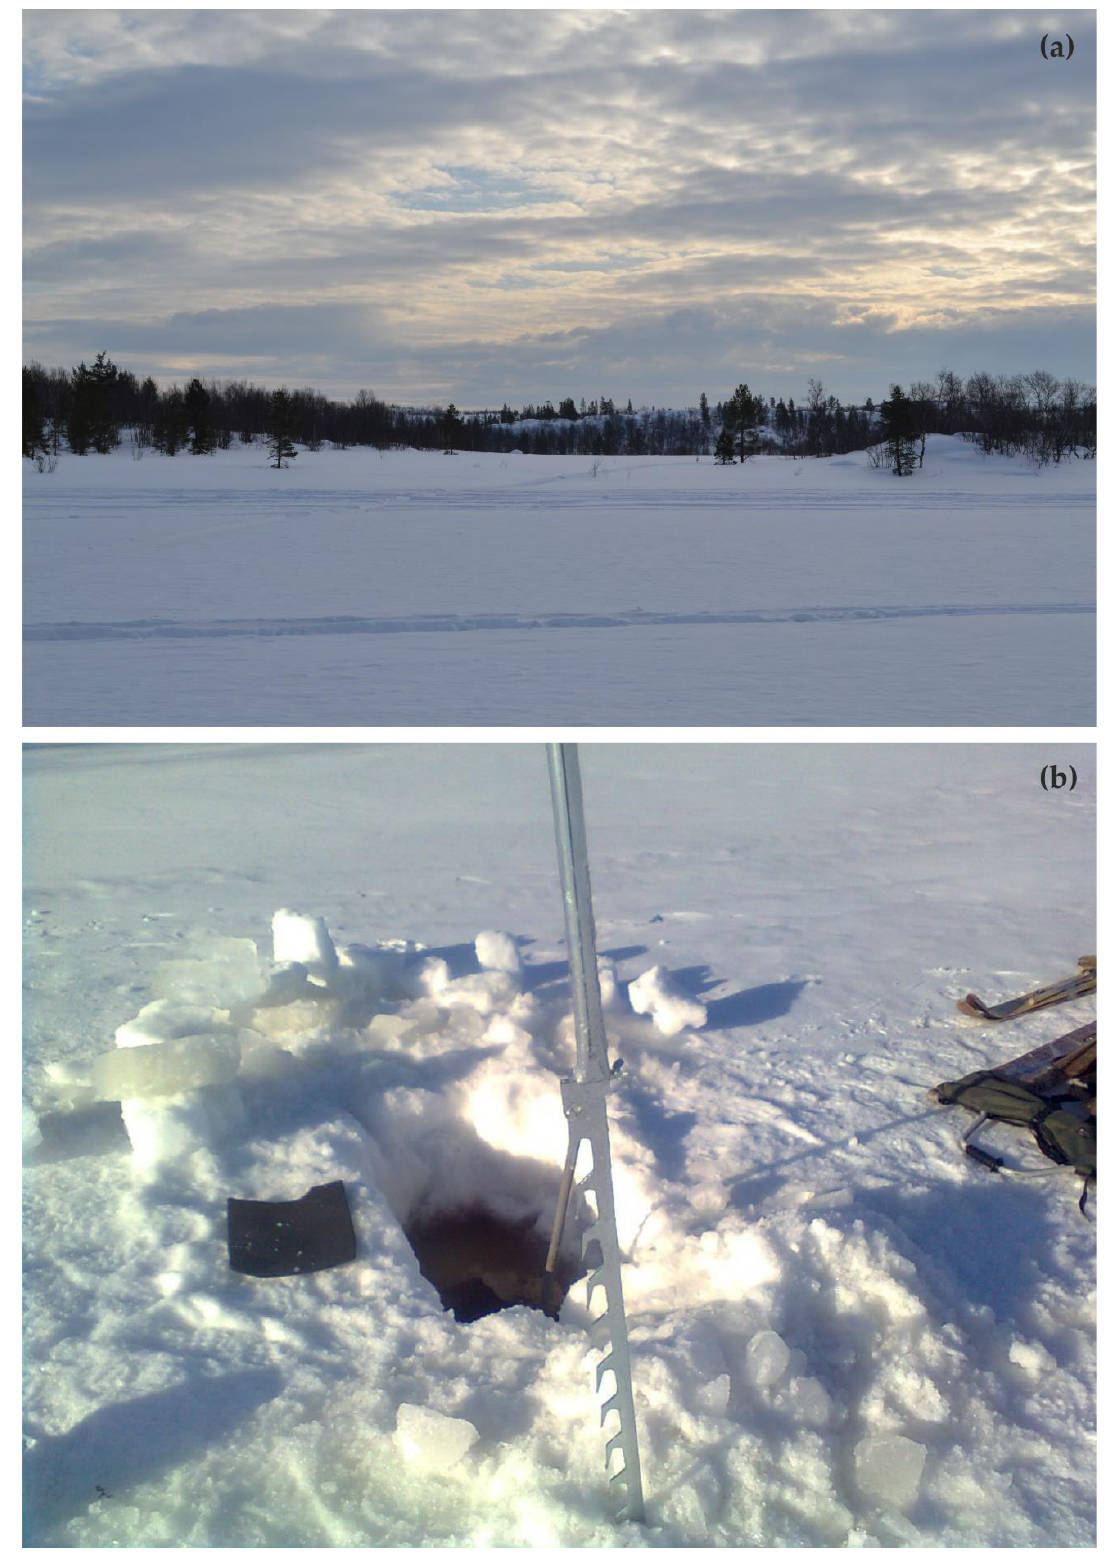
Figure 1. Lake Kulonga, March 2016. North-eastern coast, snow thickness 40 cm ( a ); a hole for zooplankton sampling, ice thickness 63 cm ( b ).